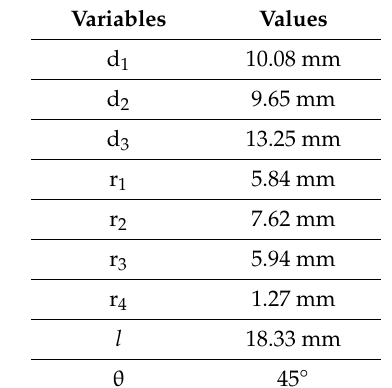
Table 2. Dimensions of simulated irregular bellows.